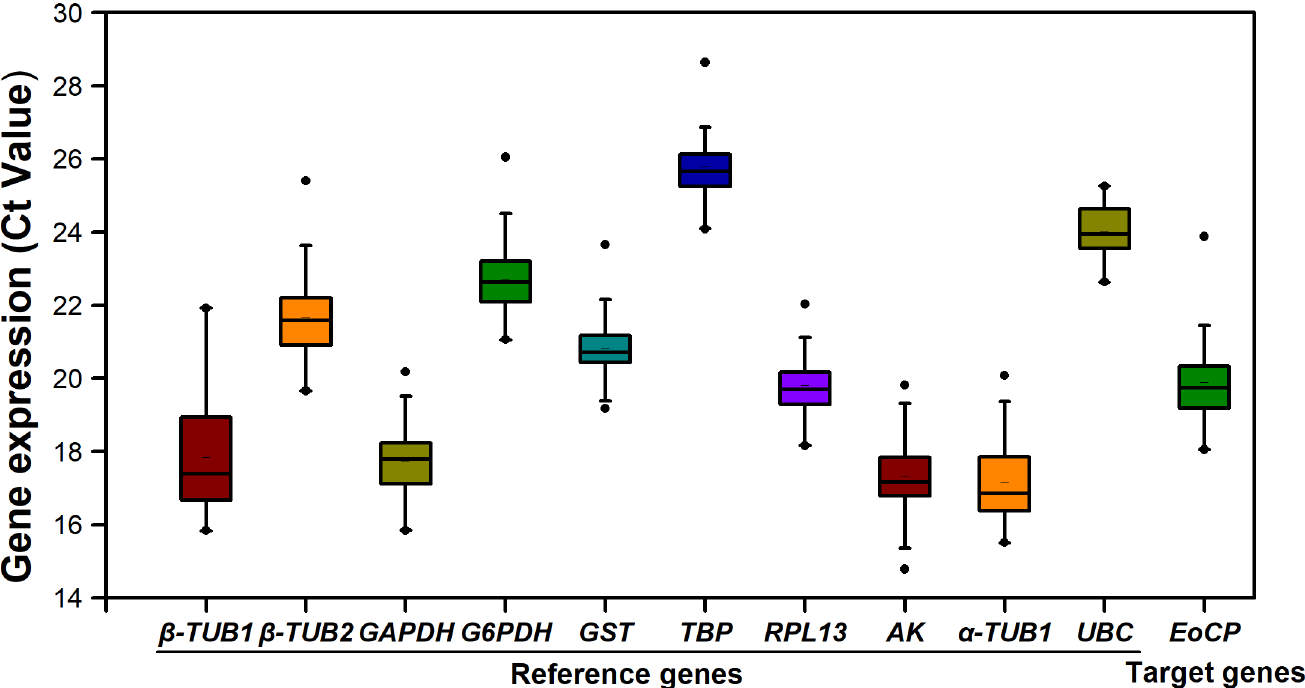
Fig 1. Expression profiles of Candidate Reference Genes in E . onukii . The expression level of RGs in all samples is documented in terms of the cycle threshold number (Ct value). The data are expressed as box-whisker plots; the short bar in the box refers to Ct mean value; the box represents the 25th–75th percentiles; the median is indicated by a bar across the box; the whiskers on each box represent the distribution of the Ct values; and the dark spots refer to extreme outliers.